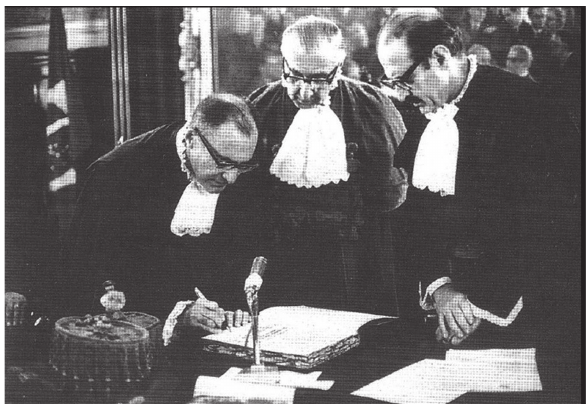
Fig. 9 – Posse como Professor Titular de Clínica Cirúrgica,